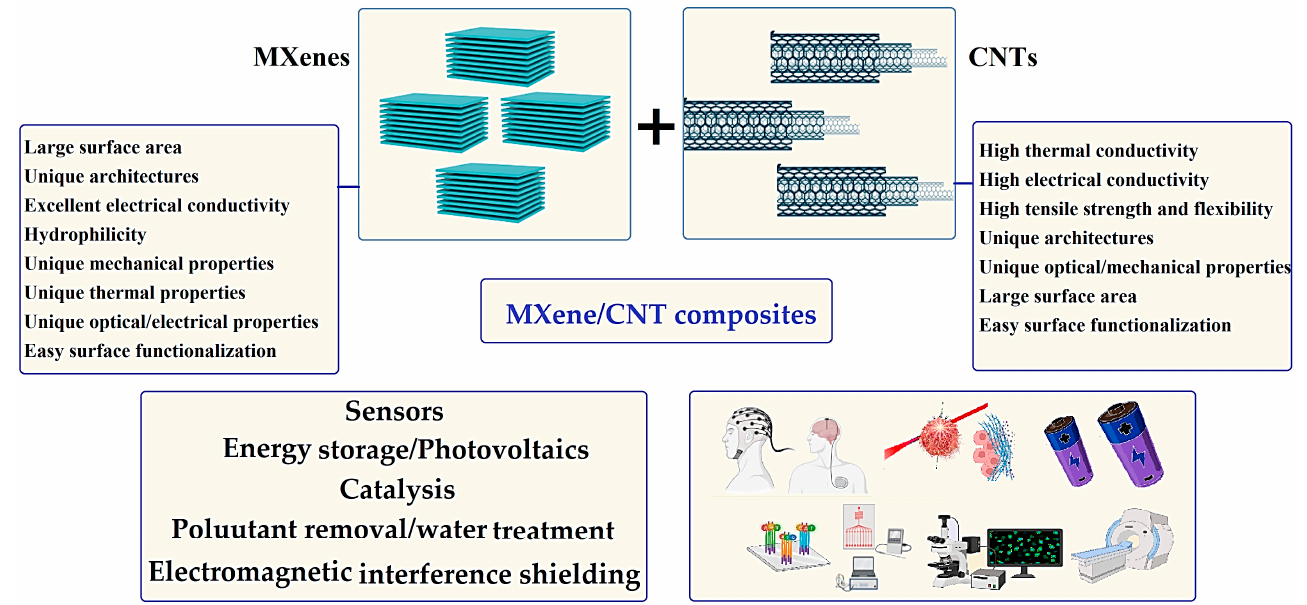
Figure 1. MXene-CNT composites with alluring potentials.